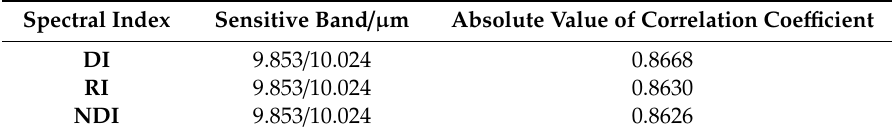
Table 2. Sensitive bands and correlation coefficients corresponding to different spectral indices.